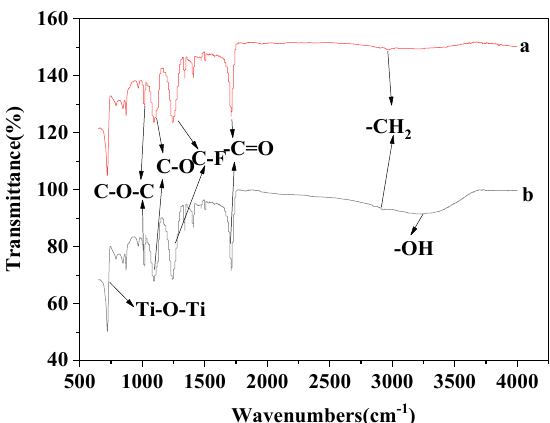
Figure 6. Figure 6. The infrared spectroscopy analysis of the ( a ) PVDF membrane and the ( b ) NTG/PVDF membrane.